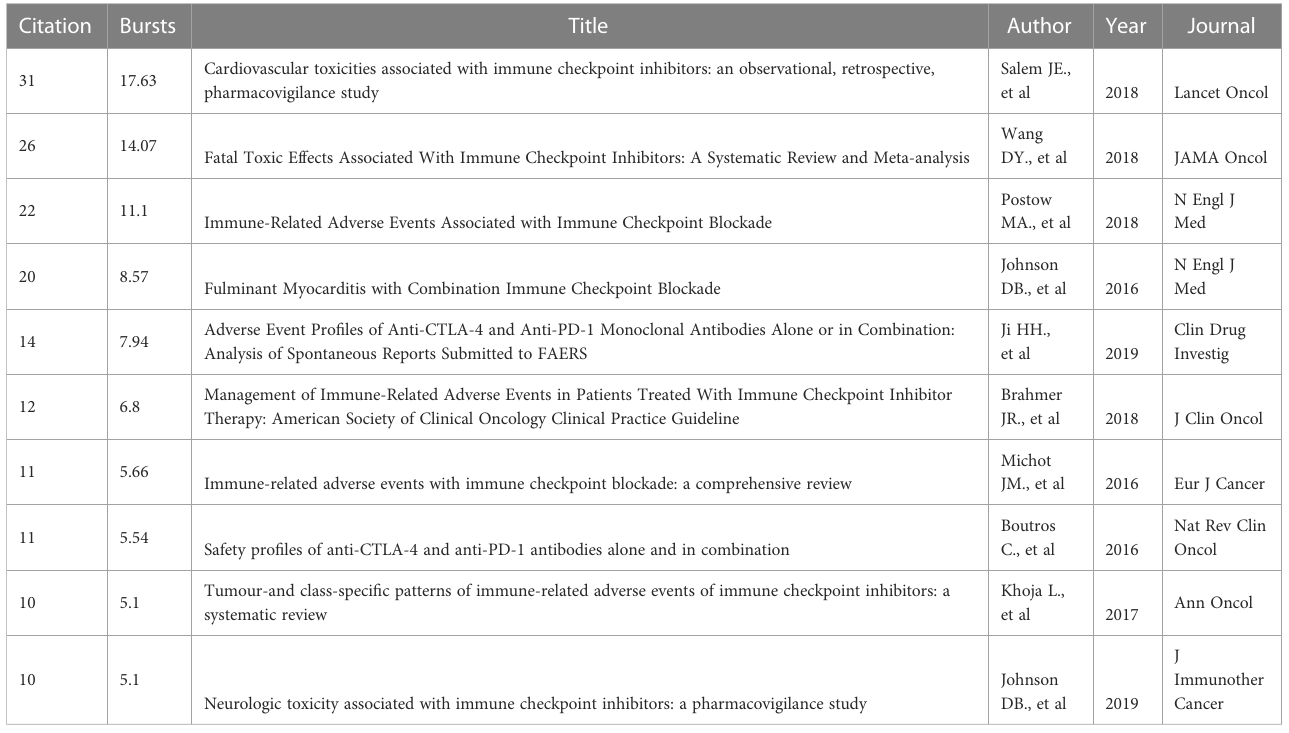
fi eld ’ s evolution track and stage characteristics. In general, cluster modularity values (Q) > 0.3 indicate a signi fi cant cluster structuring, while average silhouette values (S) > 0.5 imply that the clustering is